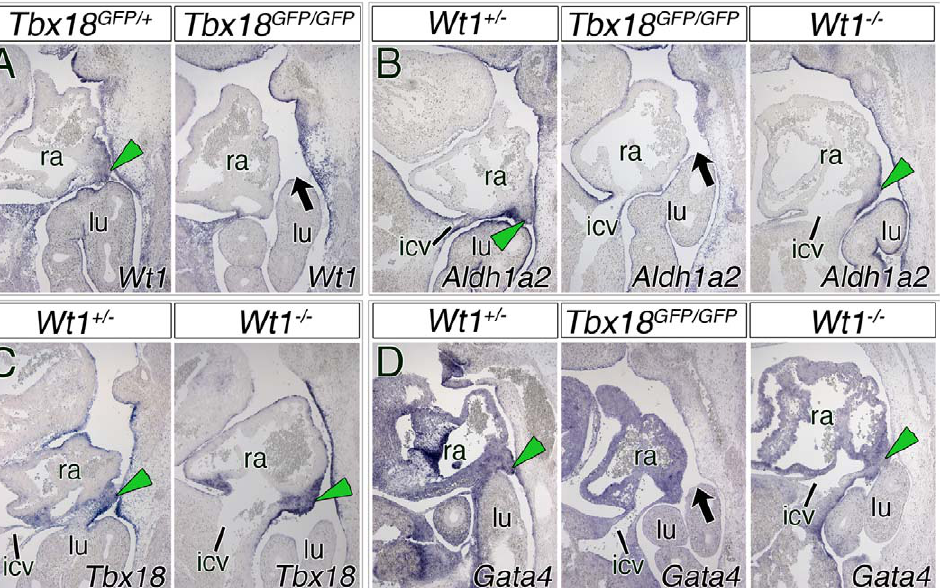
Figure 7. Gene expression in and around the sinuatrial ridges in Wt1 - and Tbx18 -mutant hearts. (A–D) In situ hybridization analysis of Wt1 (A), Aldh1a2 (B), Tbx18 (C) and Gata4 (D) on sagittal sections trough the venous pole region of control, Wt1 - and Tbx18 -deficient hearts at E11.5 and E12.5. Genotypes and stages are as indicated. Green arrowheads point to the mesenchymal ridges that are important for the closure of the PPCs in control embryos; black arrows mark the remaining PPCs. icv, inferior cardinal vein; lu, lung; ra, right atrium.